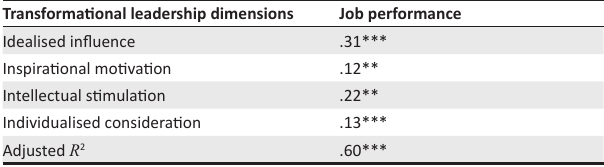
TABLE 3: Linear regression analysis estimates for transformational leadership dimensions and job